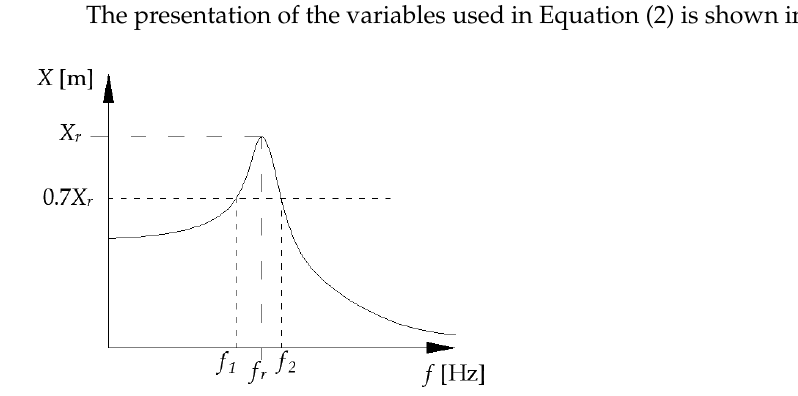
Figure 5. Schematic presentation of the half-power bandwidth method using the displacement spec- trum. X r —displacement amplitude, f r —resonant frequency, f 1 and f 2 —corresponding frequencies to 0.7 value of resonance amplitude.